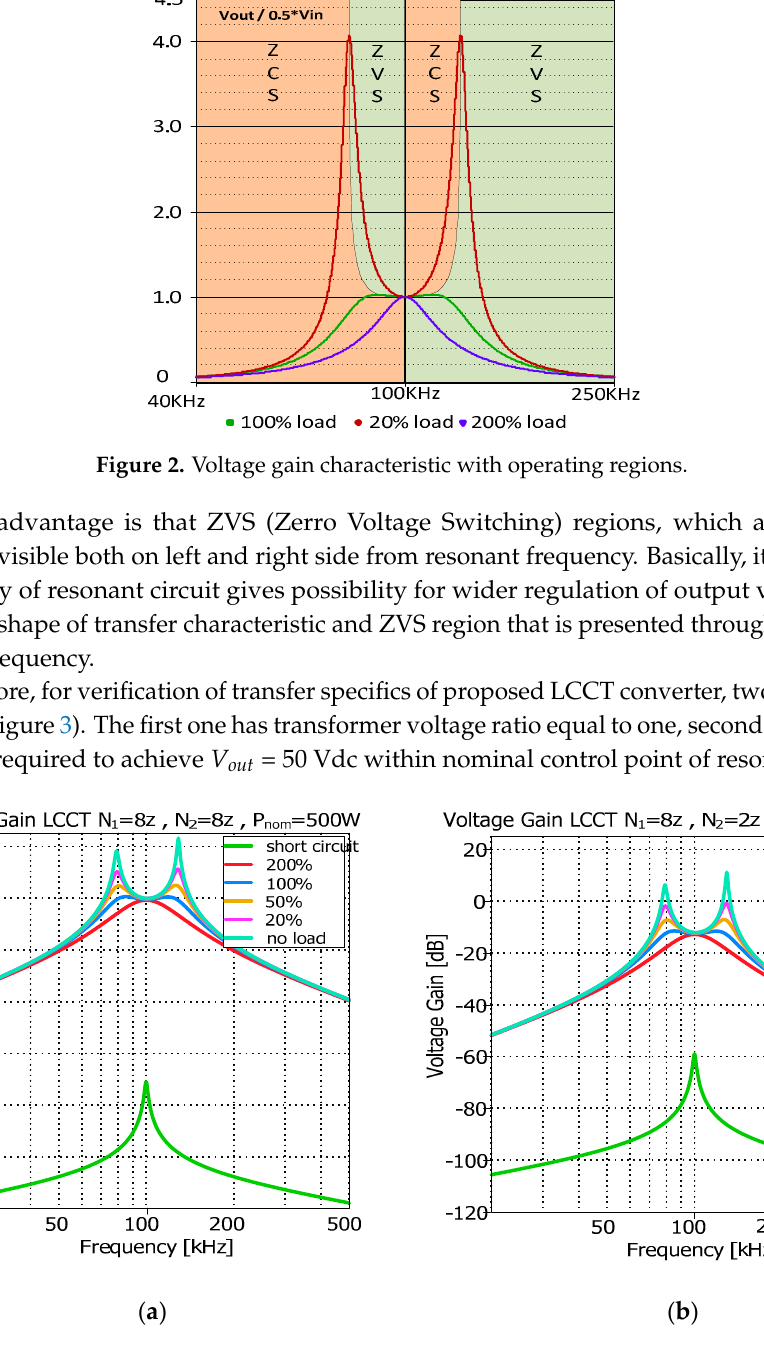
Figure 3. Impact of turn ratio on the voltage gain of resonant tank, ( a ) ratio 1:1, ( b ) ratio